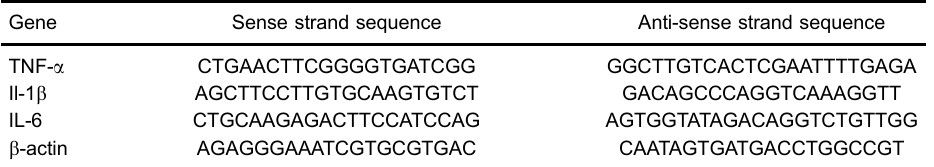
Table 1. Primers used for real-time PCR